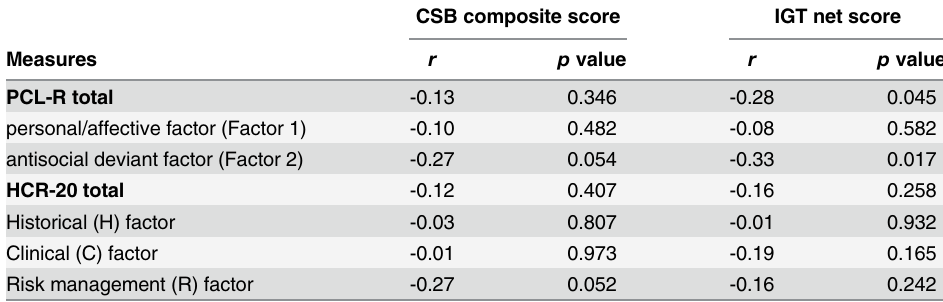
Table 3. Partial correlations between scores of measures on violence risk and neuropsychological performances in forensic patients.